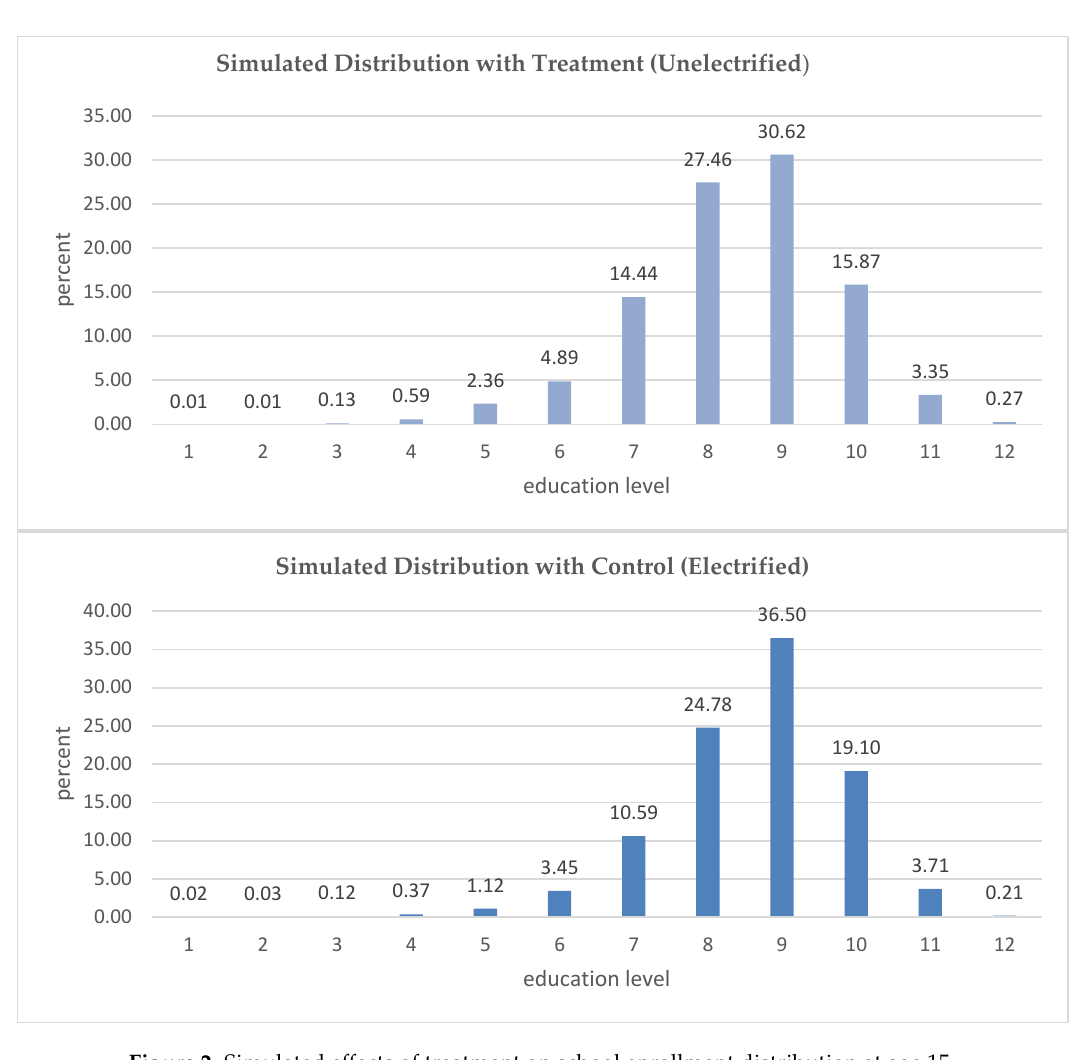
Figure 2. Simulated effects of treatment on school enrollment distribution at age 15.